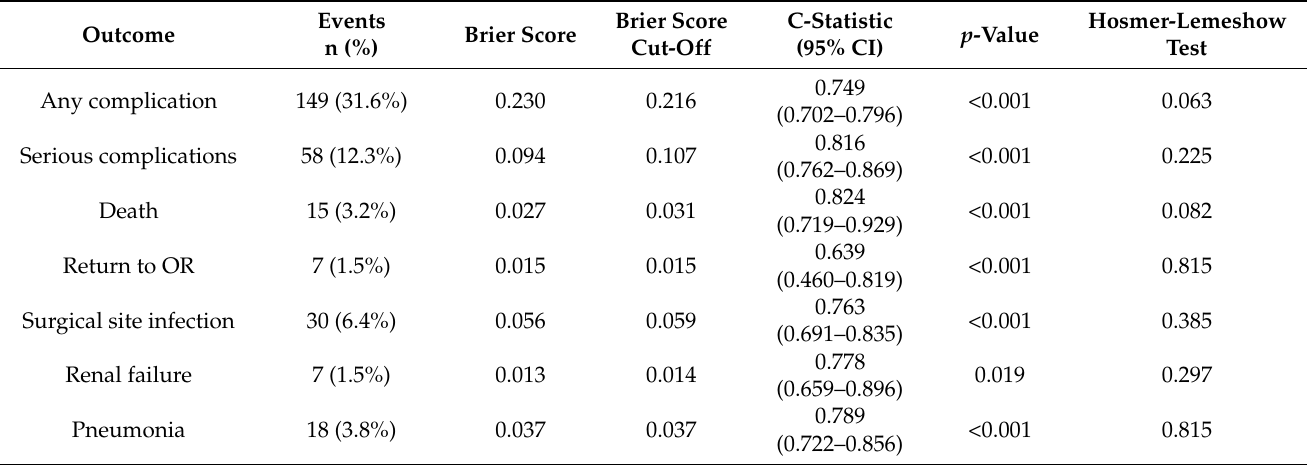
Table 2. Performance measures of the ACS-NSQIP Risk Calculator for post-operative outcomes in Greek elderly patients undergoing general surgery procedures between 2012–2017.